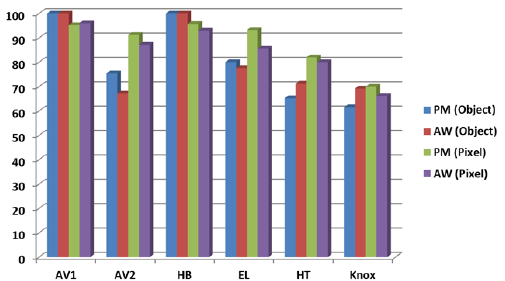
Figure 9: Object and area-based completeness comparison of building detection process. PM (object) and PM (pixel) represent the object and pixel-based completeness of the proposed method. AW (object) and AW (pixel) correspond to the same for Awrang- jeb’s method. The X-axis labelling represents the data sets.